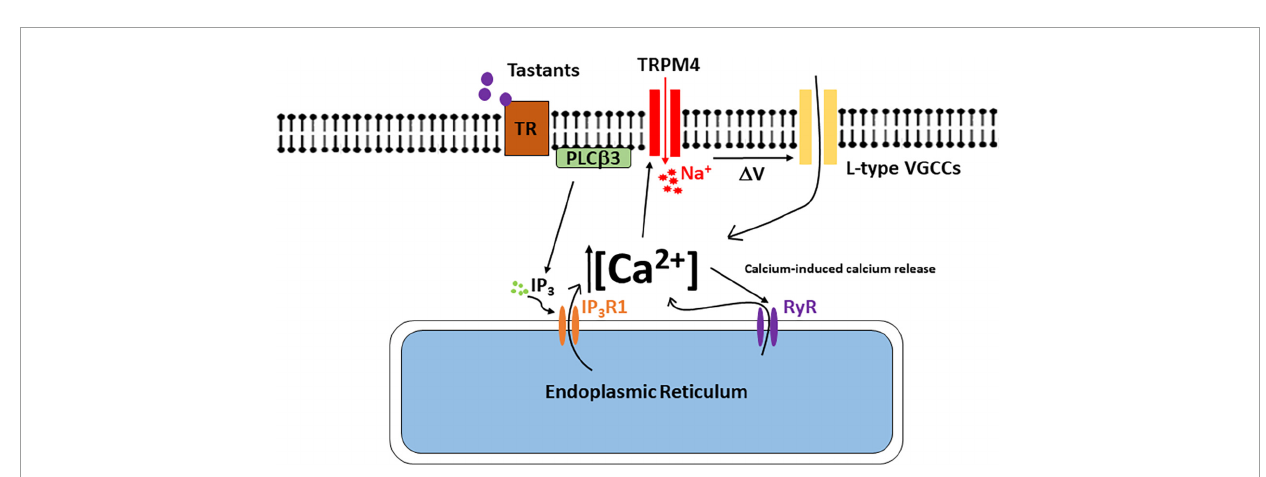
FIGURE8 The model of signaling events in the BR Type III cells. Bitter, sweet, and/or umami stimuli bind to the taste receptor and activate the PLC β 3 signaling pathway. Activation of this signaling pathway causes calcium release from the internal stores which activates TRPM4. Na + ions enter the cell through TRPM4 and depolarizes the cell to activate L-type VGCCs either directly or via changes in action potential activity. Ca 2 + influx though L-type VGCCs also generates a CICR signal via ryanodine receptors. This CICR signal enhances TRPM4 activation to further depolarize the cell and activate additional L-type